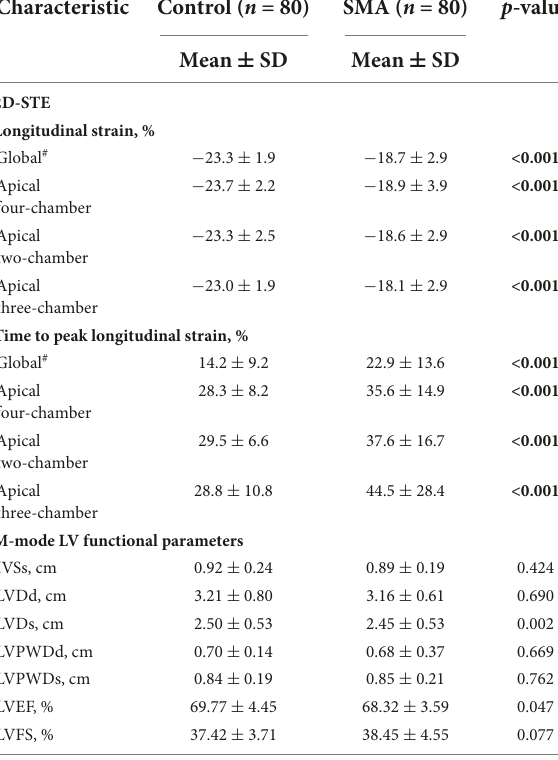
TABLE 2 2D-STE assessment of LV strain and time to peak strain and M-mode assessment of LV function parameters of SMA and control groups.